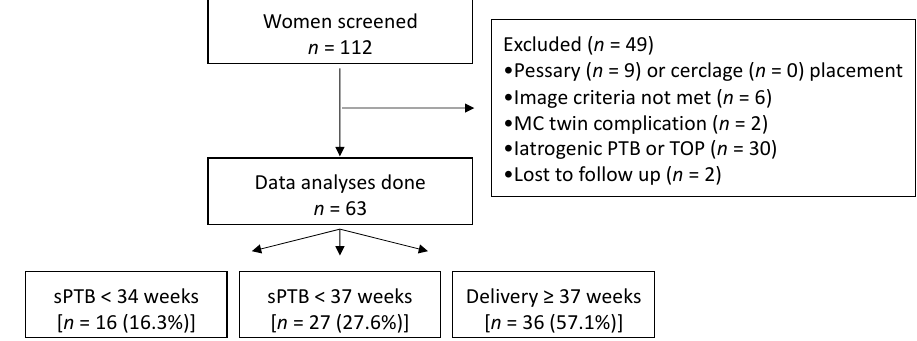
Figure 2. Flowchart summarizing the recruitment of women. Abbreviations: sPTB, spontaneous preterm birth; MC, monochorionic; TOP, termination of pregnancy.